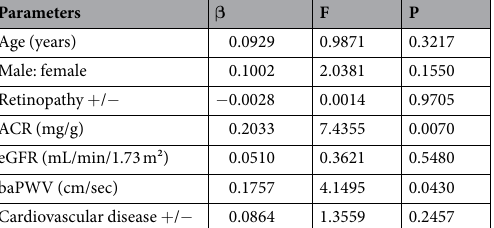
Table 3. Correlation between characteristics of DM patients and serum level of α 2 -macroglobulin: least square multivariate analysis. ACR = albumin creatinine ratio, eGFR = estimated glomerular filtration rate, baPWV = brachial–ankle pulse wave